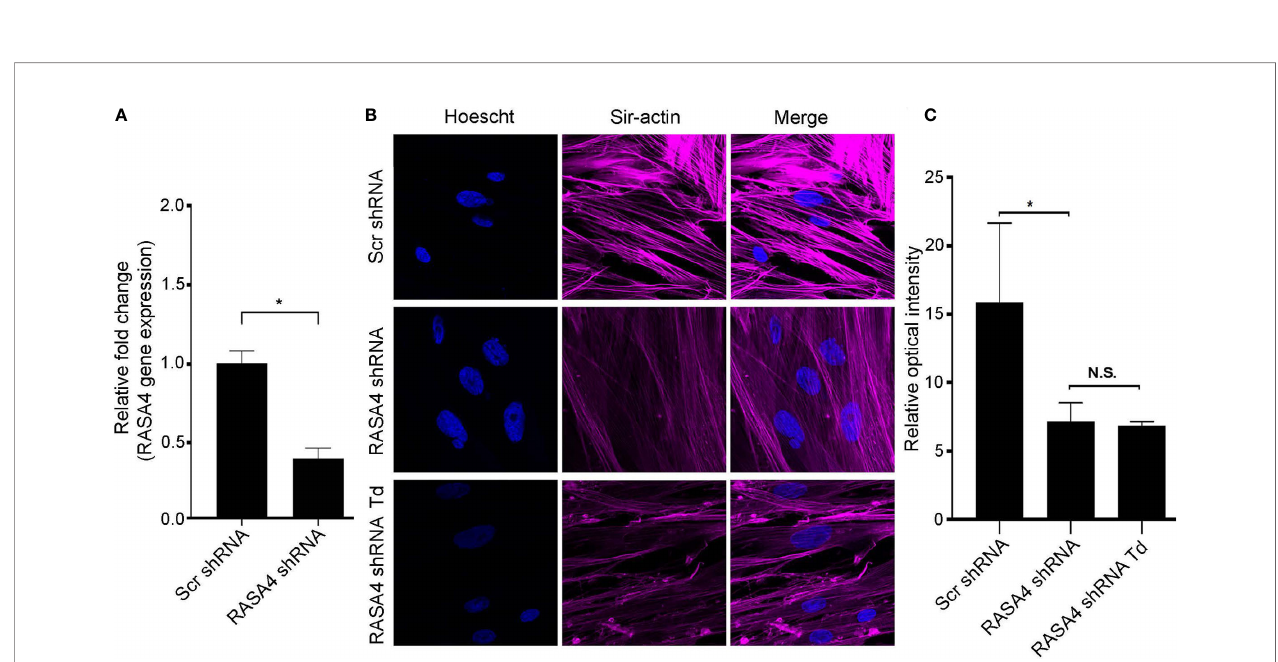
FIGURE 6 | RASA4 gene expression is required for T. denticola -mediated actin stress fi ber dysfunction. (A) Quantitative RT-PCR analysis of RASA4 relative fold change in PDL cells infected with scramble shRNA or RASA4 shRNA. (B) Representative confocal images and (C) relative optical intensity of stress fi ber intensity in scramble shRNA, RASA4 shRNA and RASA4shRNA cells challenged cells with T. denticola (50 MOI) for 24 h and stained with SiR-Actin dye (1:5000). Data represent mean ± SD from three independent experiments. Data in panel (A) was analyzed using an Unpaired t test. Data in panel (C) was analyzed using One-way ANOVA Tukey ’ s Multiple comparisons test. * = p<0.05; N.S., Not signi fi